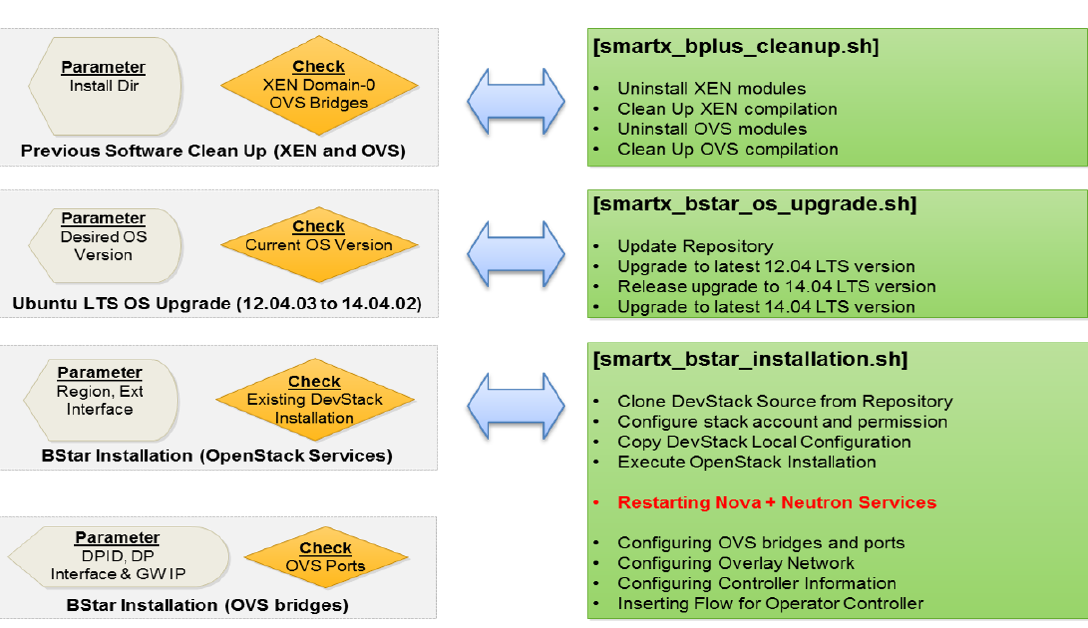
Figure 8. Implementation of Semi-automated Provisioning for SDN/cloud-enabled Hyper-converged SmartX